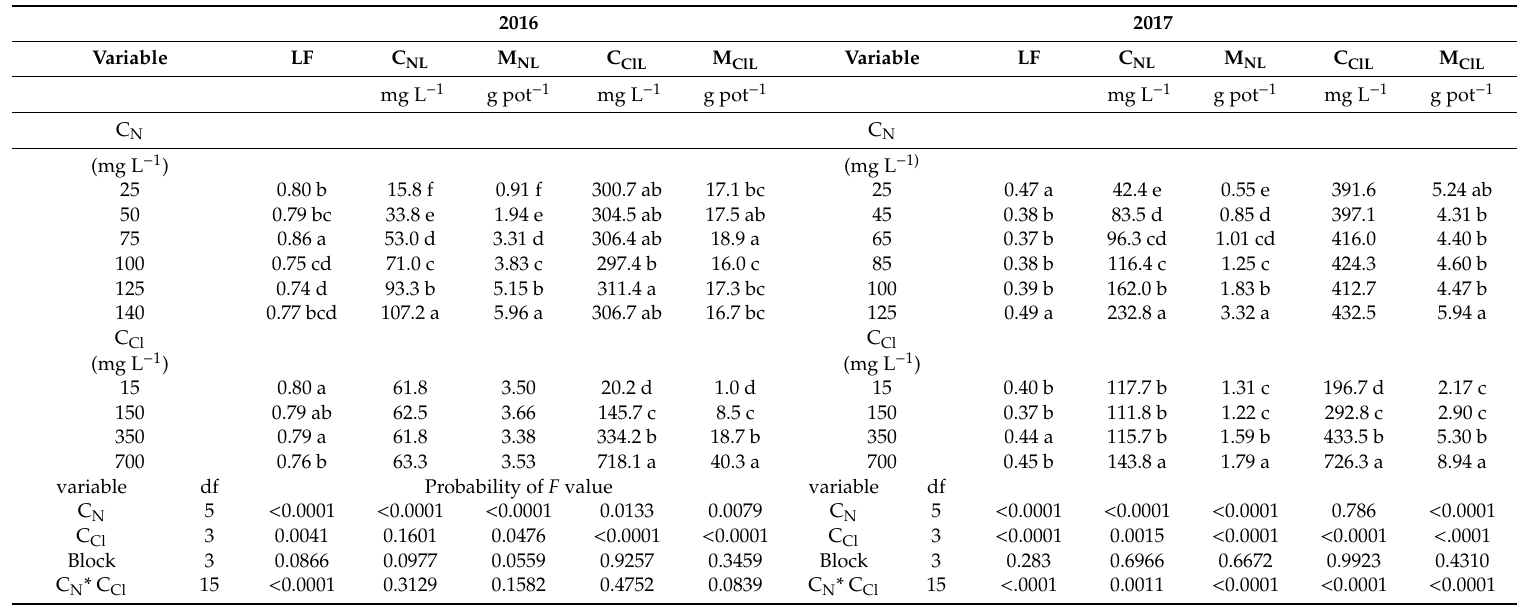
Table 8. Leaching fraction, the concentrations of N and Cl in the leachate (C NL and C ClL ) and the mass of N and Cl in the leachate (M NL and M ClL ) and the ratio of M NL of the applied N of the lettuce experiments. Probability of F values for C N , C Cl , Block factors, and the interaction of C N and C Cl were determined using the two-way ANOVA procedure of JMP 14. Di ff erent letters on the right side of values indicate significant di ff erence between treatments (HSD) at p < 0.05 by the Tukey–Kramer honestly test. No letters are presented when no significant di ff erence was